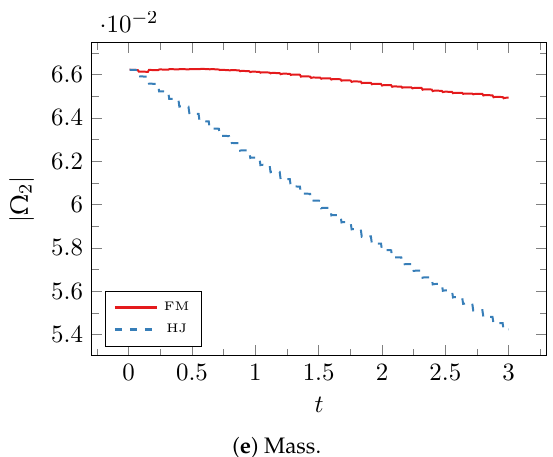
Figure 5. Comparison between the Fast Marching method (FM) and the Hamilton-Jacobi (HJ) method for test case 1 (ellipsoidal drop). The characteristic mesh size is h =